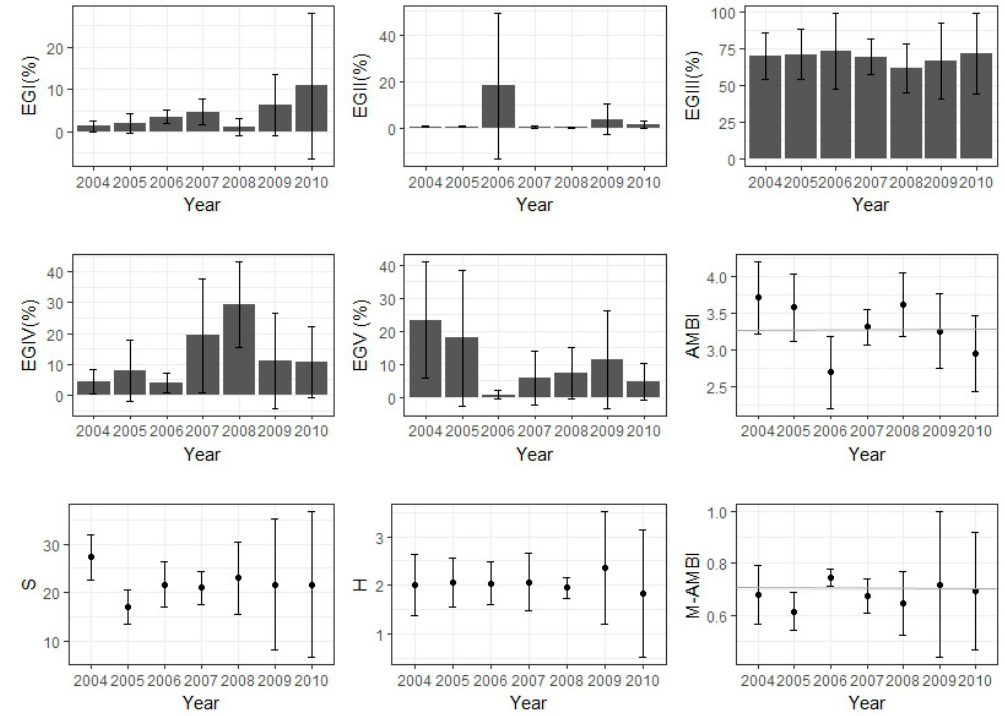
Figure 4. Annual mean (±SD) of percentage of Ecological Groups (sensitive species = EGI, indifferent = EGII, tolerant = EGIII, second order opportunistic = EGIV, first order opportunistic = EGV), structural indices (richness = S, Shannon index = H) and ecological indices (AMBI and M-AMBI) for macrobenthic community in Sacca di Goro from 2004 to 2010 (n = 3). Grey line = Good/Moderate threshold.